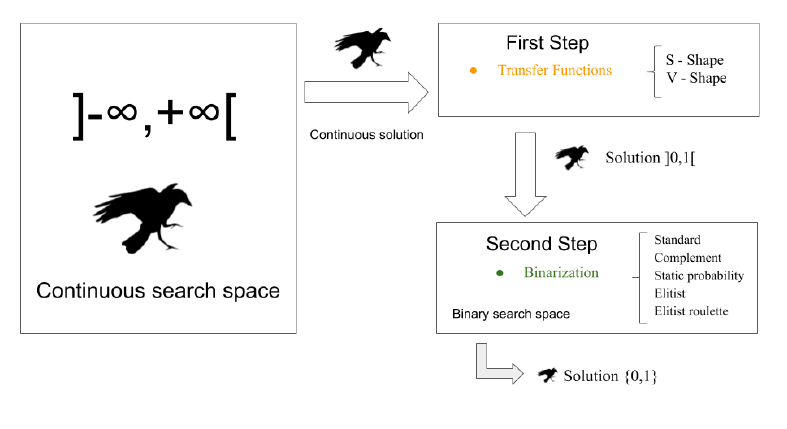
Figure 3. Continuous to Binary